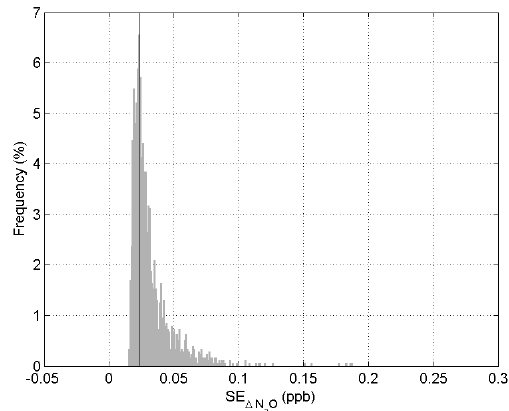
Fig. 7. Frequency distribution of SE 1 N , the standard error of 2 O 1 N 2 O. Grey bars indicate the relative frequency for each 0.001ppb bin of observed SE 1 N observed during the Spring Experiment 2 O when the 6s sampling was used. The vertical line shows the most likely value of SE 1 N 2 O